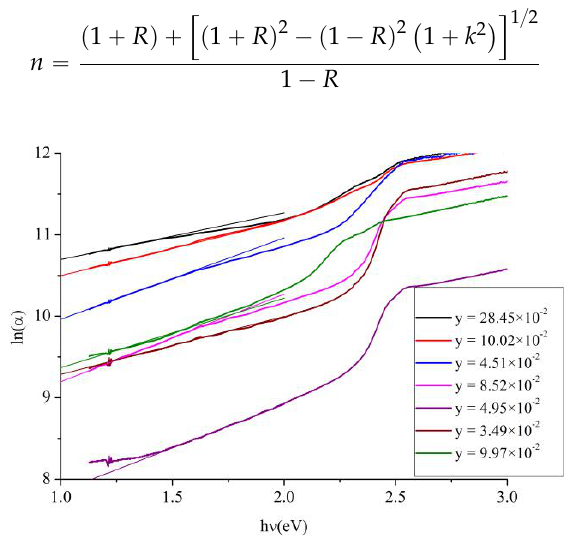
Figure 8. The relation between ln(α) and hν for CdS 1−y Te y thin films with the linear fits.